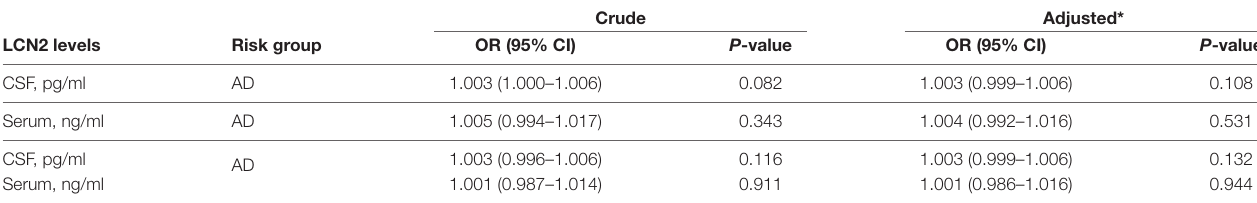
TABLE 4 | Crude and adjusted OR with 95% CI from binary logistic regression for the probability of having cognitive impairment (AD) using SCC as reference group for the Portuguese